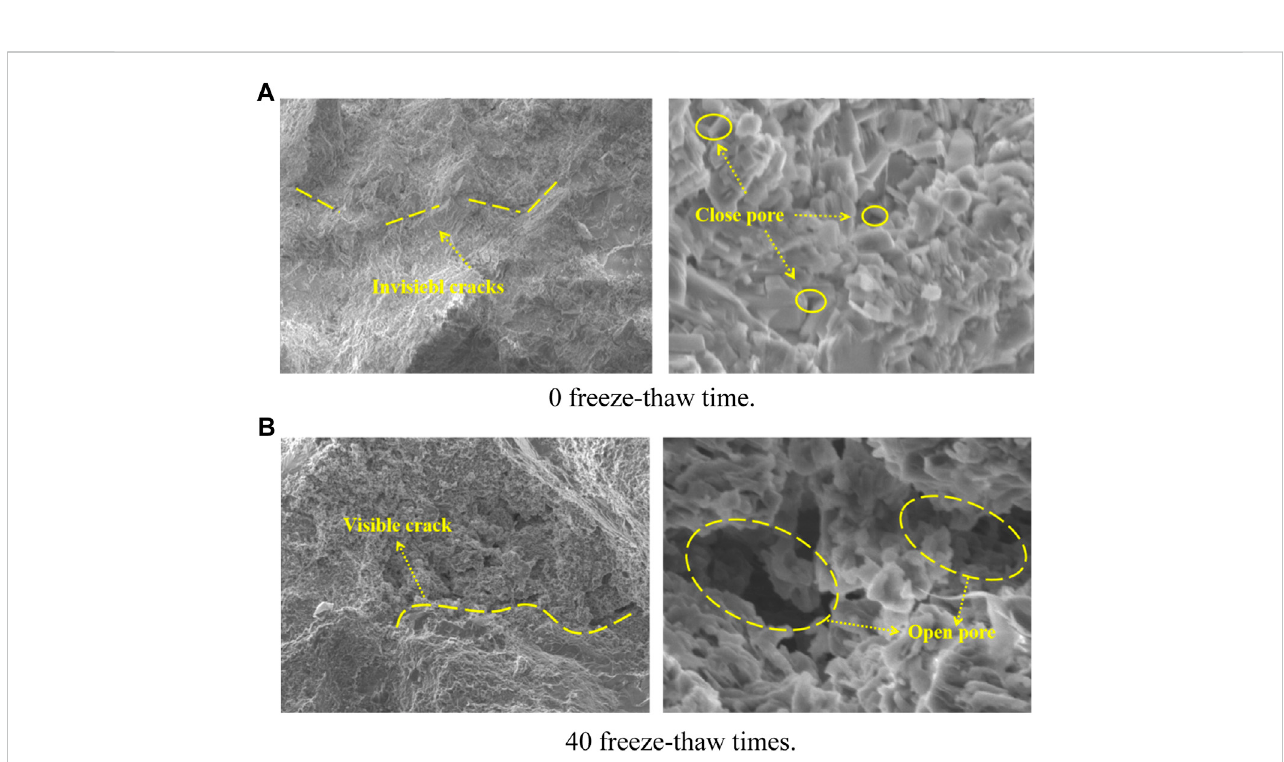
Frontiers in Earth